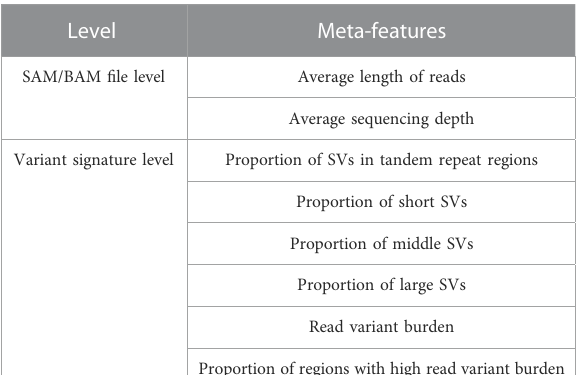
TABLE 1 Meta-features extracted to characterize sequencing